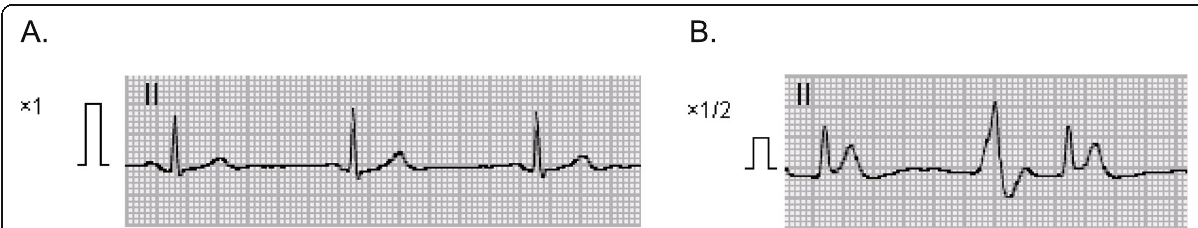
Fig. 1 ECG changes during the first episode of circulatory collapse in our patient. a Baseline ECG waveform (lead II) showing normal morphology of the QRS complexes and ST-segment. b ST-elevation and premature ventricular complexes seen in the early phase of the circulatory